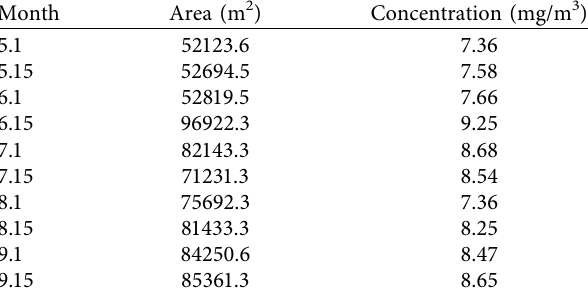
Table 2: Test results.